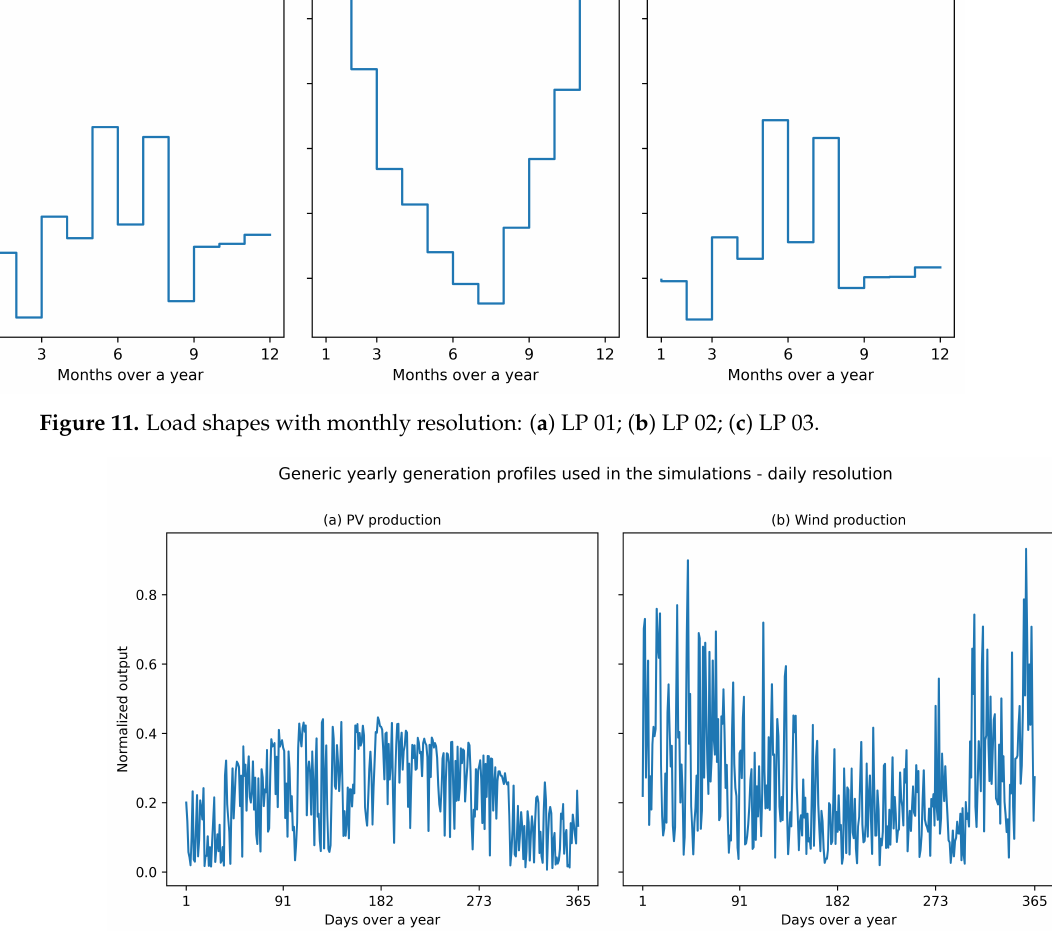
Figure 12. Production profile of DGs with daily resolution: ( a ) PV DG; ( b ) wind